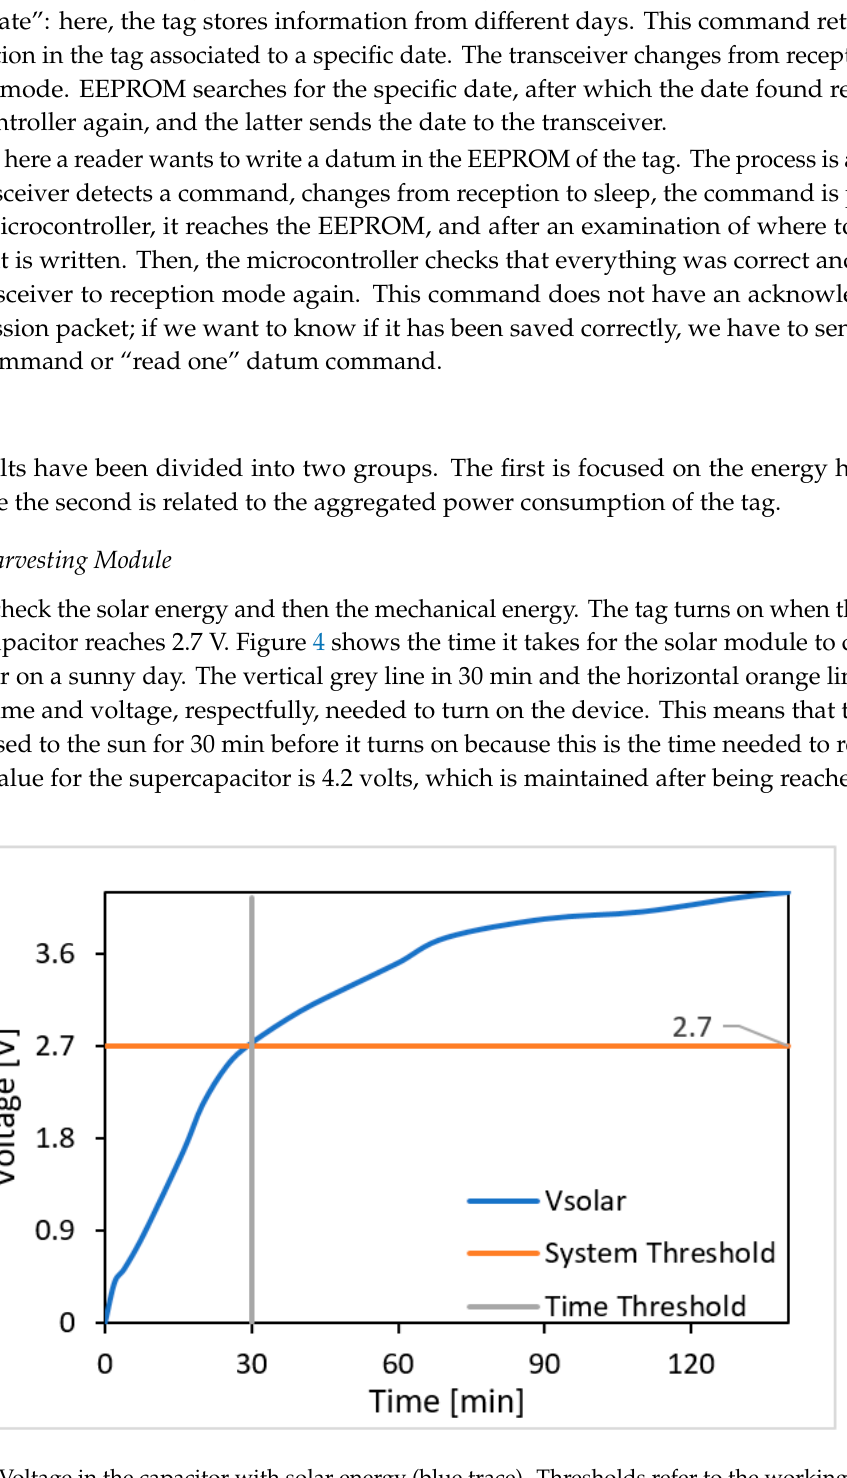
Figure 5. Voltage of supercapacitor with tag in a shady place for solar panel. There are four images that represent how the voltage changes in the supercapacitor for different days represented by the yellow line. ( a ) Shaded conditions during the night between 23 and 24 July, 2019. The voltage drops because there is no energy source. System is off. ( b ) Shaded conditions during 8 August 2019 at noon. The voltage rises but it starts at low value, so this increase is not enough to turn on the system. System is off. ( c ) Shaded conditions during 9 August, 2019 at noon as ( b ), but for more hours. The voltage rises and the start point of the voltage is close to the threshold that turns on the system, so the system turns on; however, when system is on it needs more energy, which explains why it always oscillates